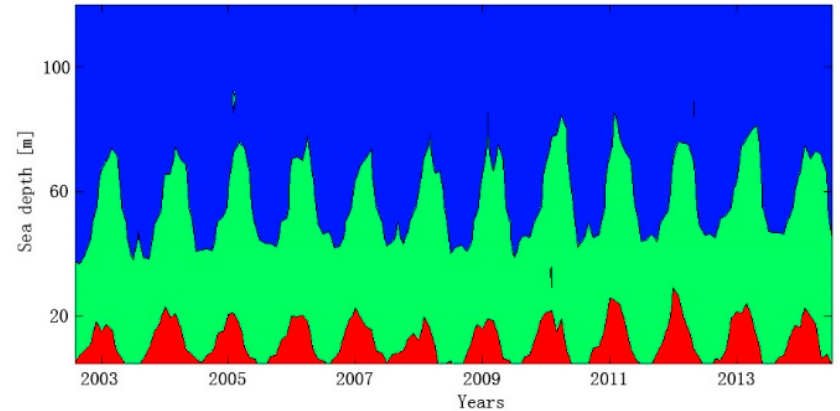
Figure 10. Spatial and temporal changing patterns of water quality in the CECZ seas for ( a ) Oligotrophic (blue color), ( b ) Mesotrophic (green color), and ( c ) Eutrophic (red color) waters. The coastal zones with water depth Z s < 120 m were included in the analysis, as all waters in zones with Z s > 120 m fell into oligotrophic types in the CECZ seas.